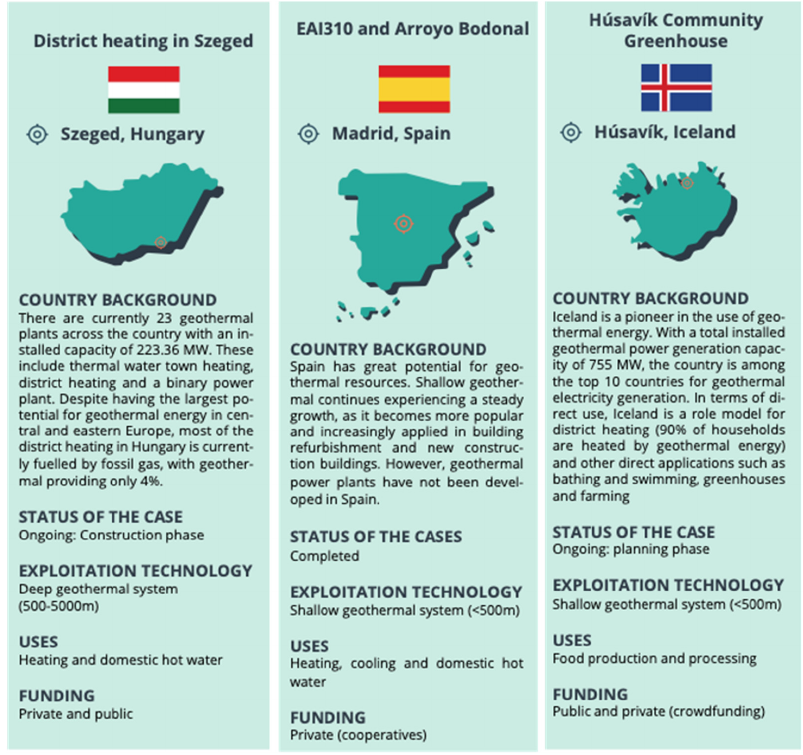
Figure 3. CROWDTHERMAL case studies